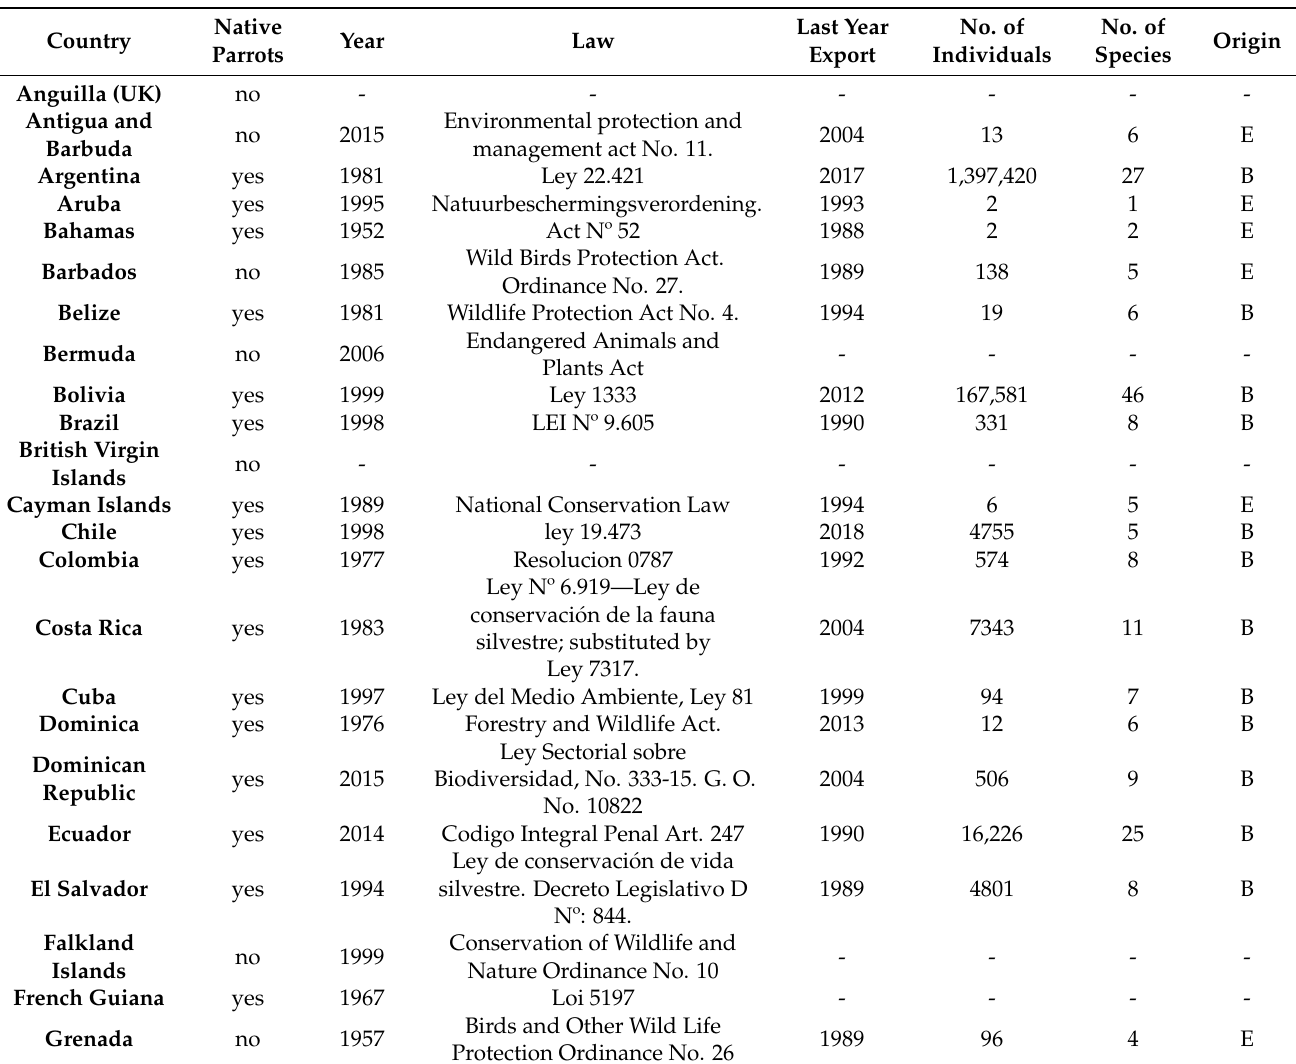
Table 1. Years in which each country prohibited trapping wild parrots for the domestic demand of pets (Year) and year of the last export of wild-caught parrots for the international pet markets (Last year export), number of individuals (No. of individuals) and species (No. of species) exported and the origin of these species (Origin: N = native from the country, E = Neotropical species but absent in the country and B = both